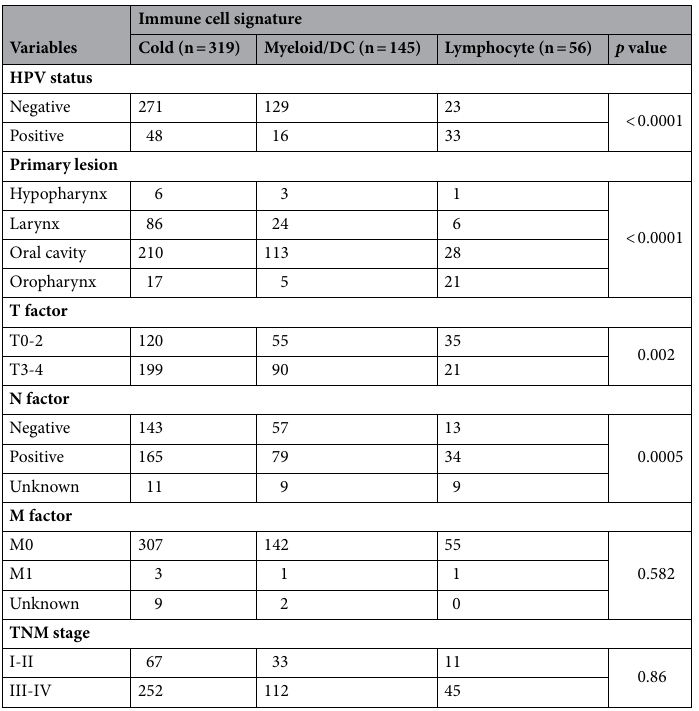
Table 1. Relationship between immune cell signature and clinical parameters in 520 patients with HNSCC. HNSCC Head and neck squamous cell carcinoma, HPV Human papillomavirus, TNM Tumor-node-metastasis, DC Dendritic